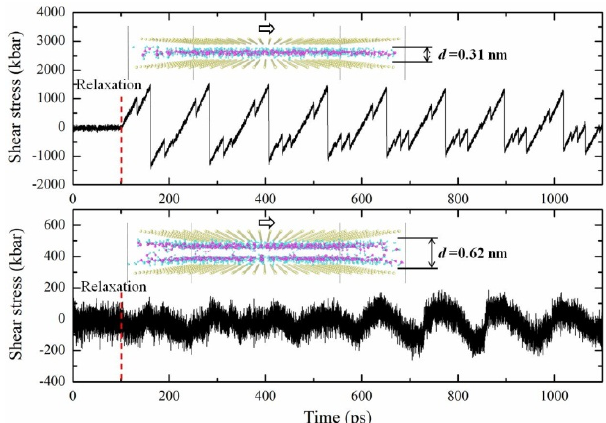
Figure 9. Shear stress of water vs. time during the slip of the upper boundary (Insets are the atomic models for molecular dynamics. Yellow oxygen atoms form upper and lower boundaries in atomic models. Cyan hydrogen atoms and magenta oxygen atoms compose water molecules. The model in the upper figure has one layer of water molecules with the thickness 0.31 nm. The model in the lower figure has two layers of water molecules with the thickness 0.62 nm.).